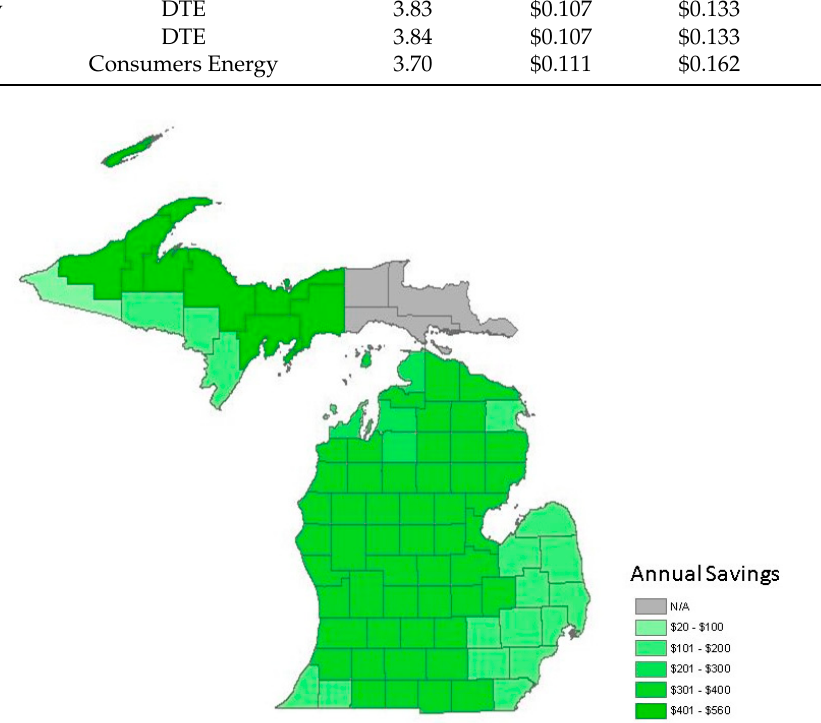
Figure 1. Savings ($/kWh) provided to each Michigan county from residential solar